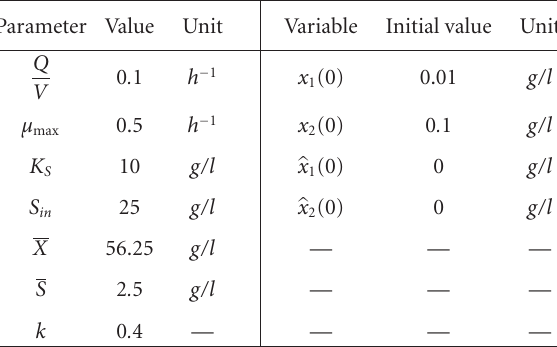
Table 1: Numerical values used for the